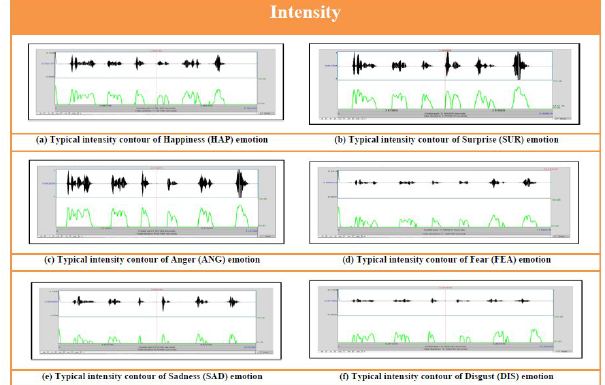
Fig. 16. European speakers typical intensity contour of basic emo- tions.